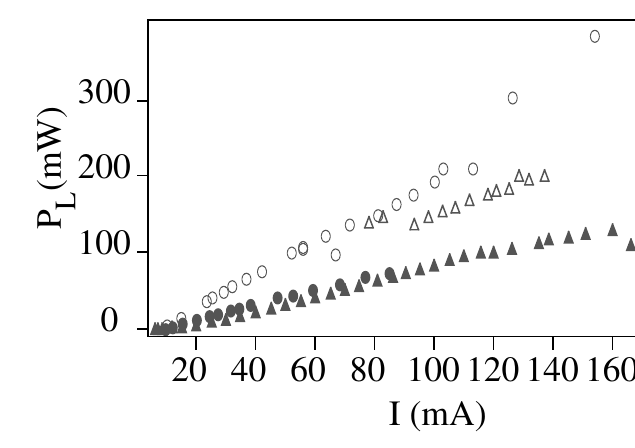
FIG. 10. FEL power versus current in the case of achromatic optics with ( (cid:2) ) P (cid:6) 0 : 3% , ( (cid:12) ) P (cid:6) 0 : 12% , and chromatic optics with ( (cid:3) ) P (cid:6) 0 : 3% , ( 4 ) P (cid:6) 0 : 12% .